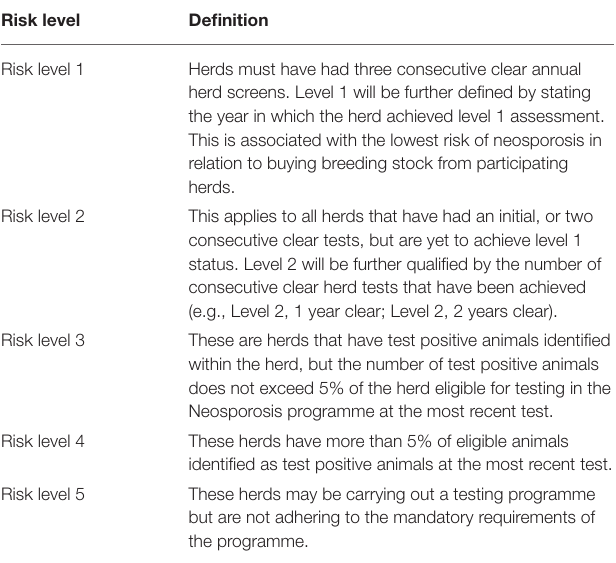
TABLE 3 | Summary of neosporosis risk level